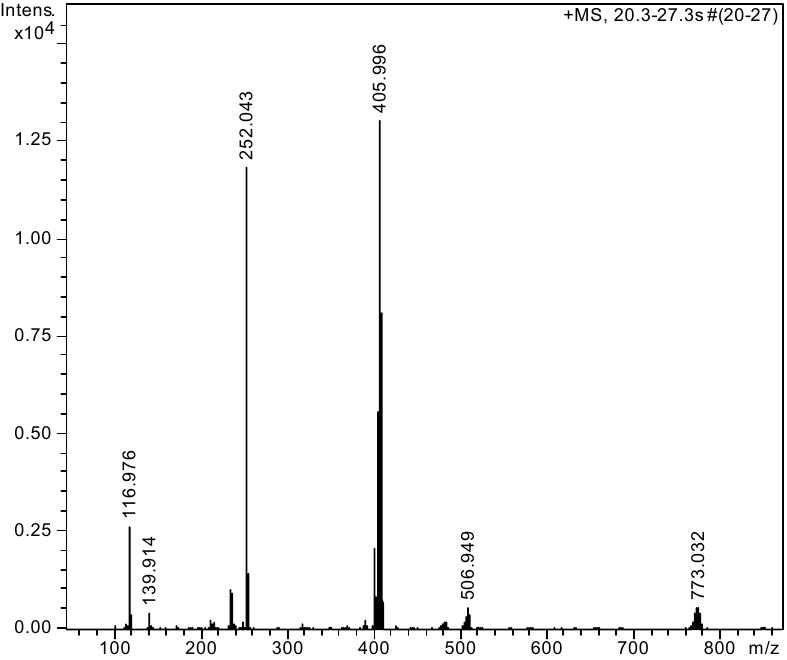
Figure 8. ESI-MS spectrum of an aqueous sample of the [( η 6 - p -cym)Ru] 2+ -Ida 2 − system at a 1:1 ratio, pH = 9.0 (c Ru = 0.1 mM).